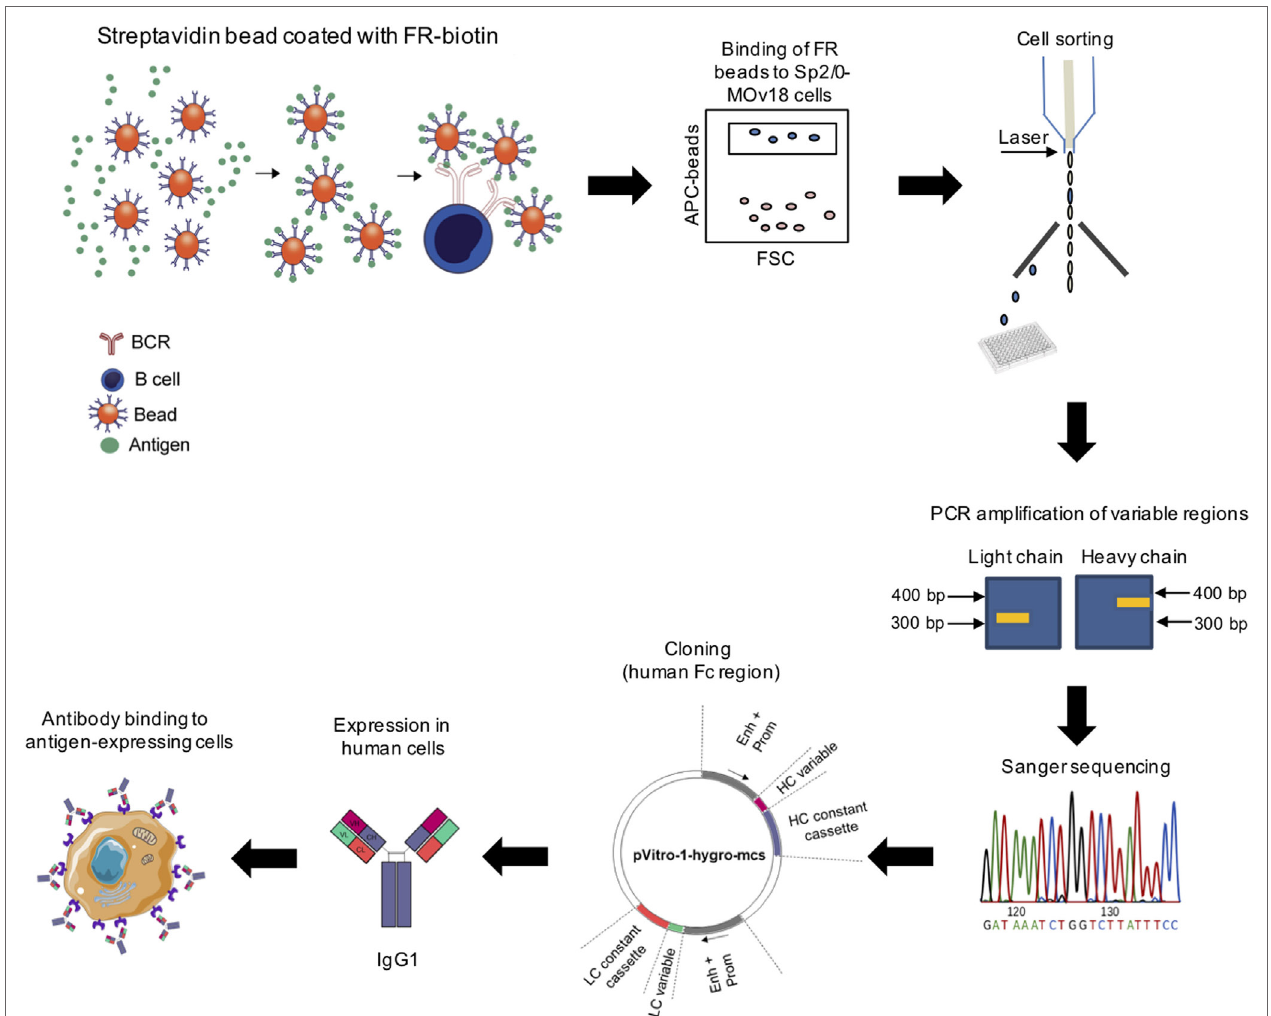
FigUre 1 | Workflow for identification of antigen-specific monoclonal antibodies derived from single cell cloning. Biotinylated antigen (Folate Receptor alpha, FR α ) was conjugated to fluorescent beads conjugated to streptavidin or avidin. Antigen-coated beads could bind cells expressing an antigen-specific immunoglobulin (Ig) and bead-bound cells were purified using cell sorting. RNA from sorted cells was reverse transcribed and Ig variable regions were amplified by nested PCR, sequenced, and cloned using the dual expression plasmid pVITRO1 containing human heavy and light chain constant region cassettes (gamma1/kappa). Antibodies were expressed in a human cell expression system, purified, and tested for antigen